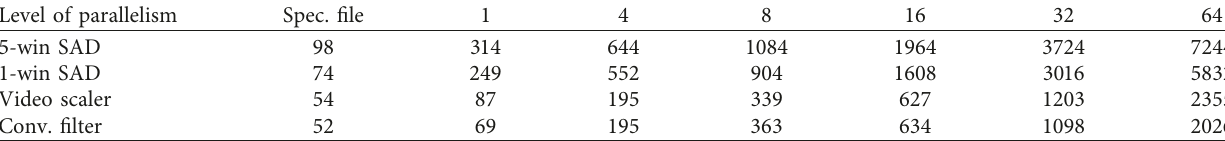
Table 3: Number of code lines generated for different applications at different parallelism levels.